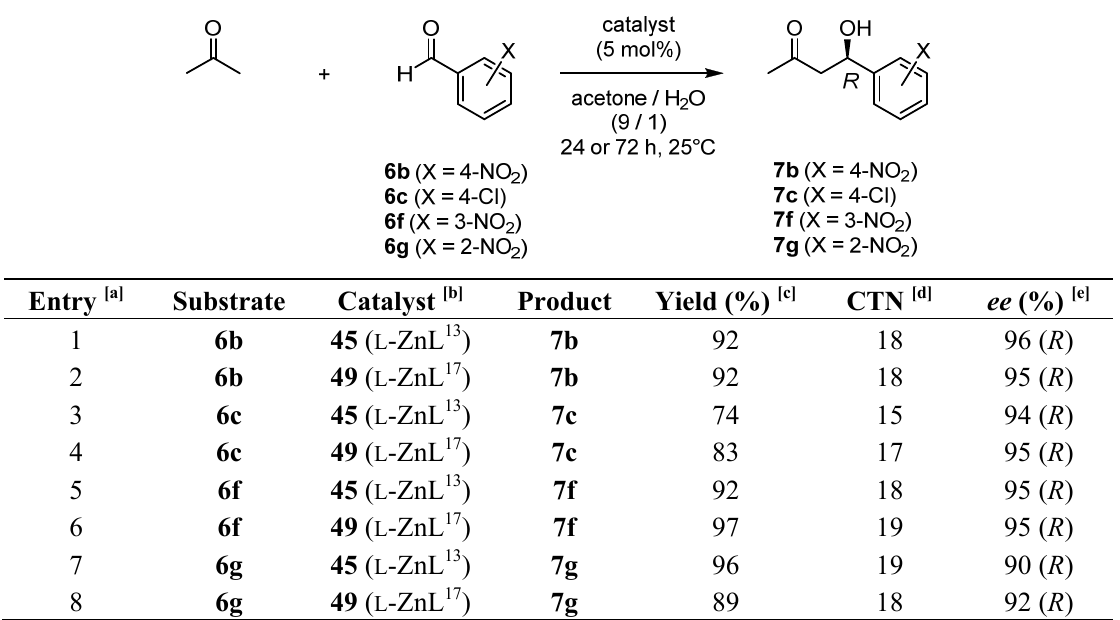
Table 4. Results for asymmetric aldol reactions between acetone and